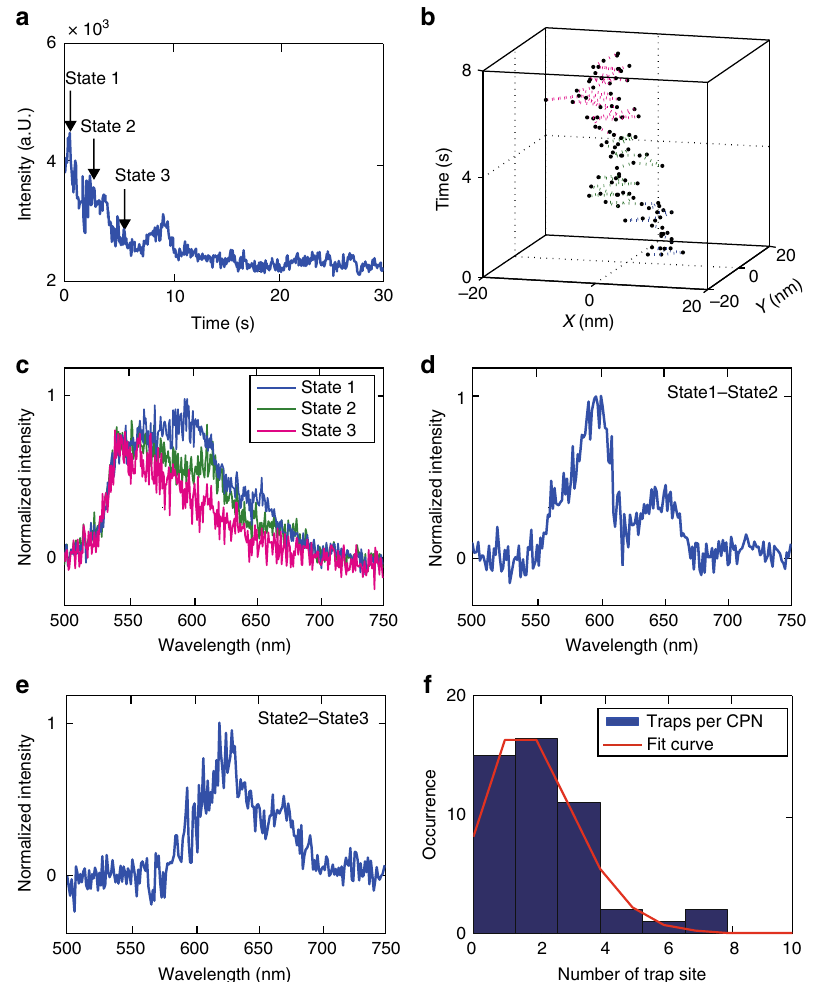
Fig. 3 Intensity decays caused by multiple hole polaron generation events. a A fl uorescence intensity trajectory showing stepwise decay at early time. b The corresponding centroid position trajectory during the fl uorescence decay, acquired at 50 Hz framerate. Different color indicates different state in the intensity decay. For plotting, every 5 points in the position trajectory were binned together to reduce noise. c Single-particle fl uorescence spectra at different states of the decay. d State1 – state2 spectrum. e State2 – state3 spectrum. For plots d and e , every two pixels along the X axis (wavelength) were binned together to reduce noise. f The distribution of number of red-emitting sites/charge carrier traps per CPN, fi tted to a Poisson distribution with λ =